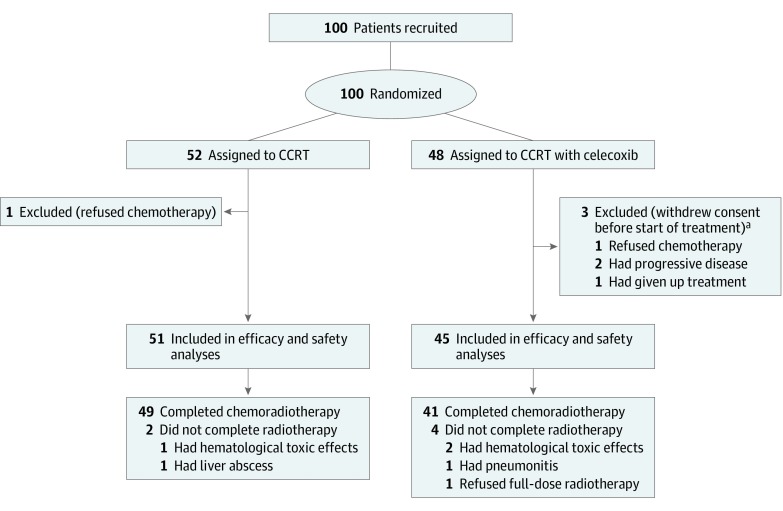
Flow Diagram for the TrialCCRT indicates concurrent chemoradiation therapy.aPatients could have more than 1 reason for exclusion.